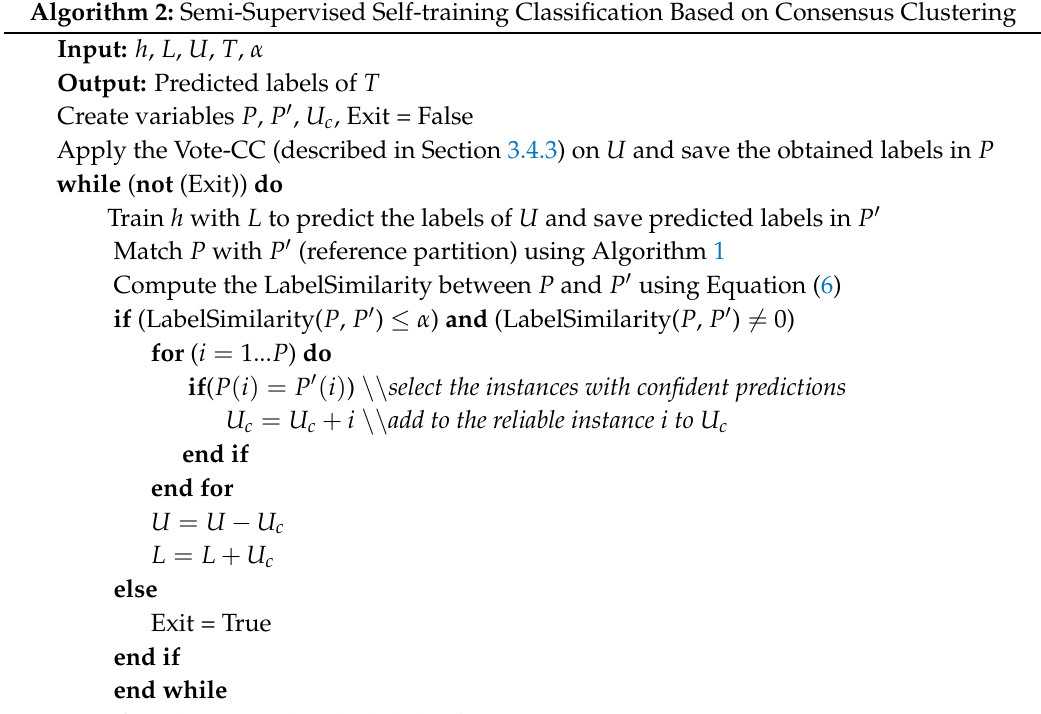
Algorithm 2: Semi-Supervised Self-training Classification Based on Consensus